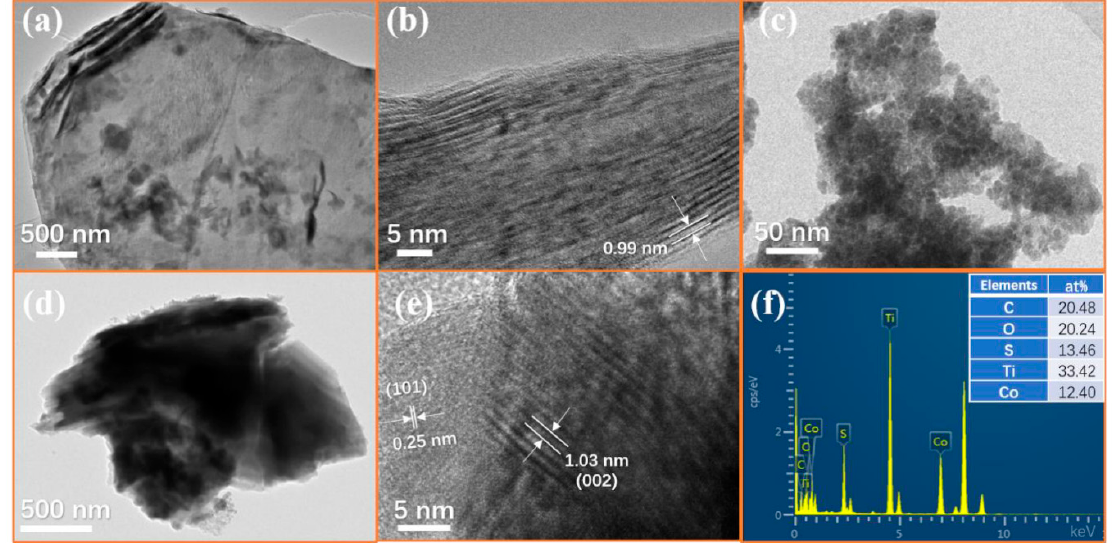
Figure 6. TEM ( a ), HRTEM ( b ) images of Ti 3 C 2 T x , TEM image of CoS nanoparticles ( c ), TEM ( d ), HRTEM ( e ) and corresponding EDS ( f ) images of CoS@Ti 3 C 2 T x .